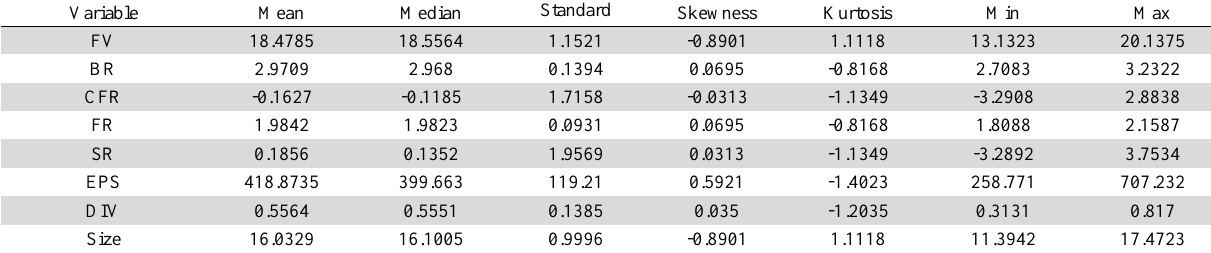
The summary of some basic statistics